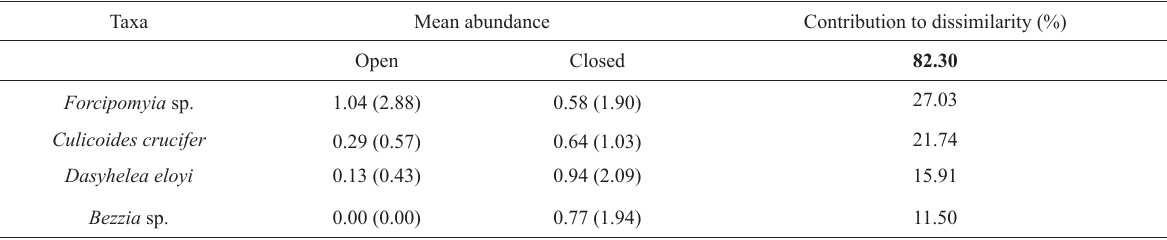
Mean abundance (SD) and results of the Similarity Percentage Tests (SIMPER) indicating the contribution of Ceratopogonidae taxa to the dissimilarity between open and closed areas in an urban forest fragment in Central Amazon. In bold, values of dissimilarity (%) between groups. Standard deviation values are given in parentheses. Taxa